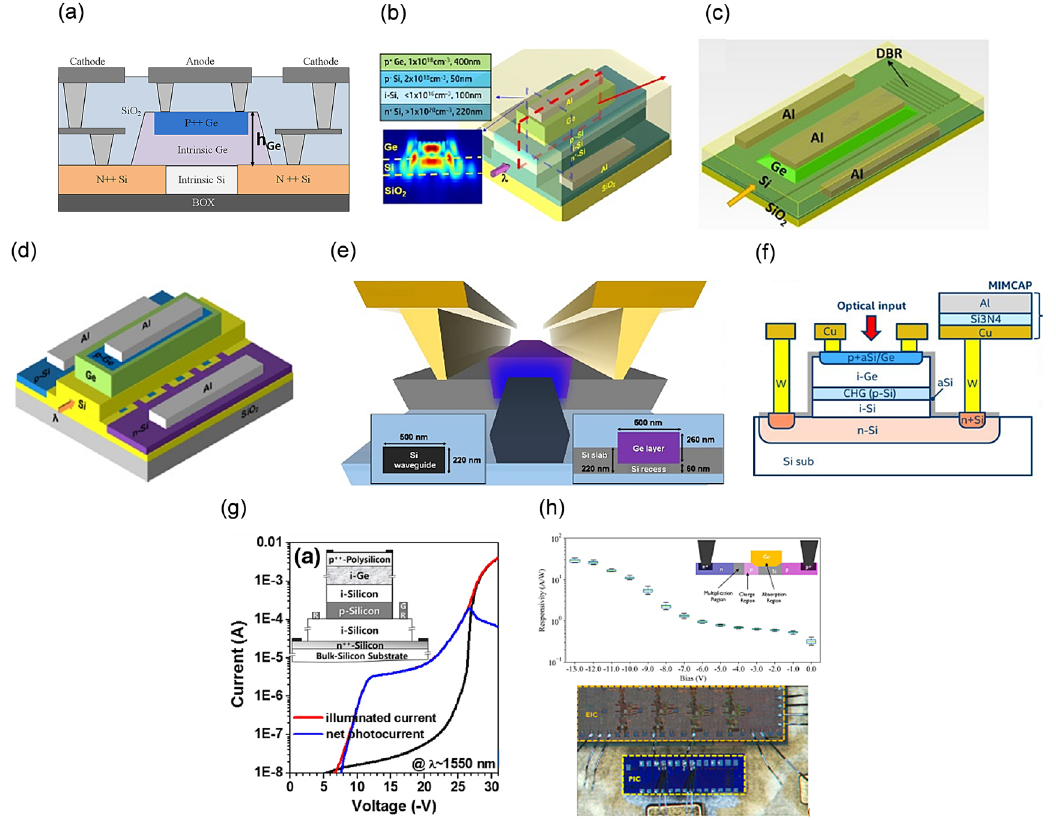
Figure 7: Photonic receivers made out of Si – Ge avalanche photodetectors. (a) 28 Gbps vertical p-i-n APD. (b) 25 Gbps receiver based on two-stage vertical SACM APD. (c) 64 Gbps vertical SACM APD with DBRs.